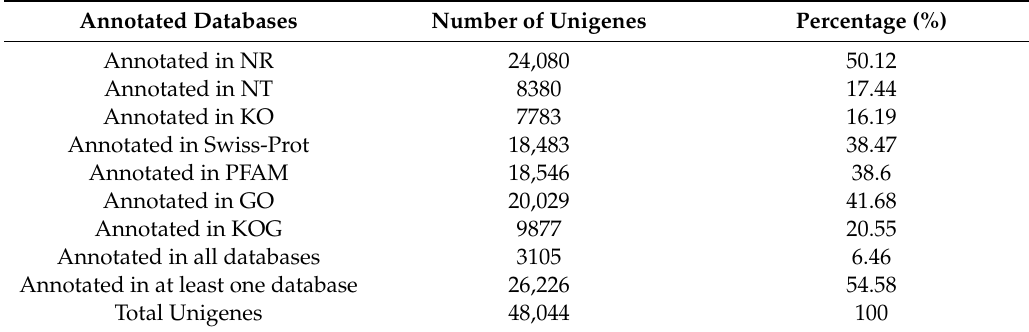
Table 1. Functional annotation of the Platycladus orientalis